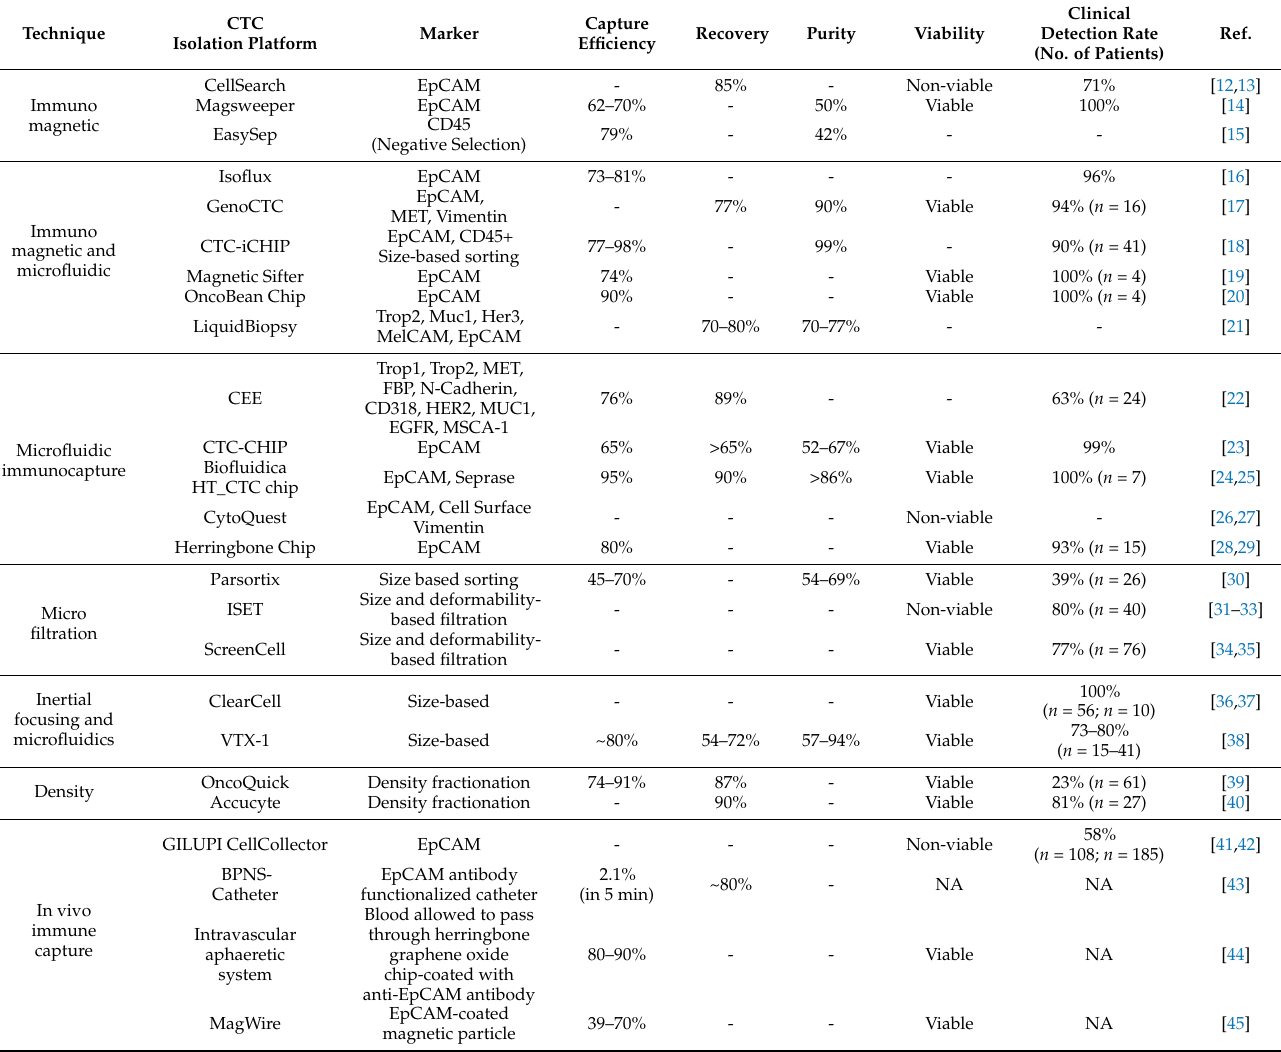
Table 1. Selected circulating tumor cell enrichment technologies and